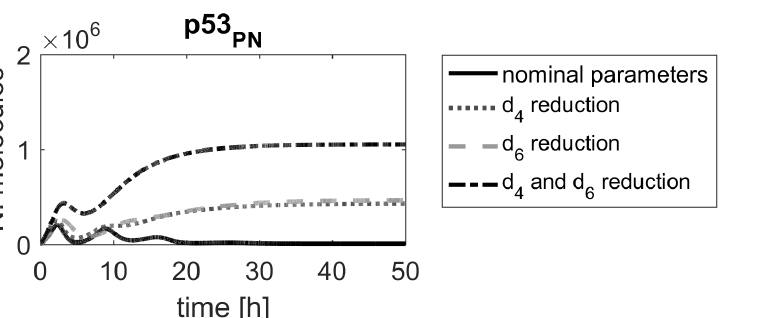
Figure 10. Comparison of p53 protein responses in the model with nominal parameters (black line) and parameters d 4 and d 6 reduced by α =